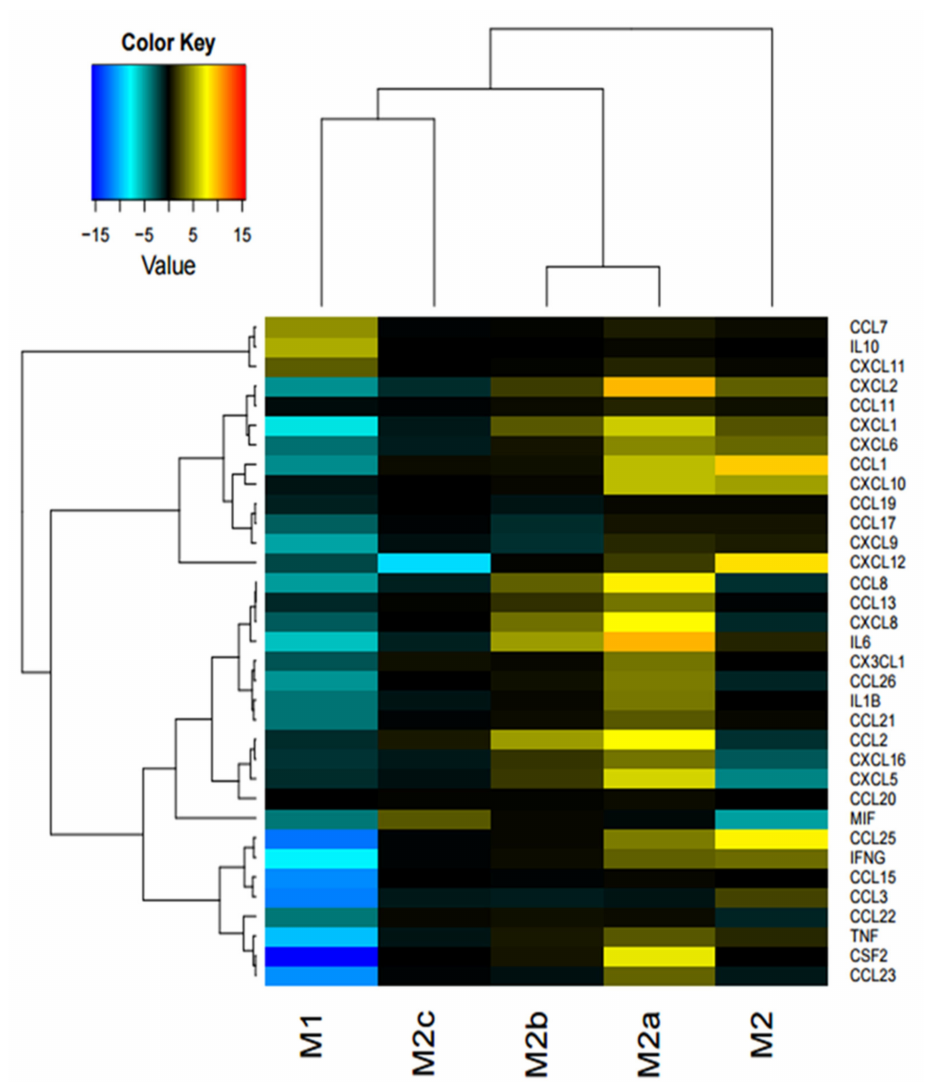
Figure 1. Cytokine secretory pattern was changed in M1 and M2 macrophages after iPSC-CM treatment. Heatmap shows the fold changes in cytokine secretion detected by Bioplex analysis in the different macrophage subtypes in response to iPSC-CM ( n = 4; Mean ±